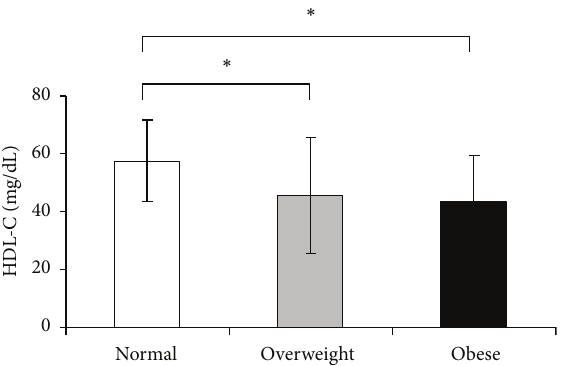
Figure 2: The serum HDL-C level (mean ± SD), according to the BMI. ∗ 𝑃 < 0.05